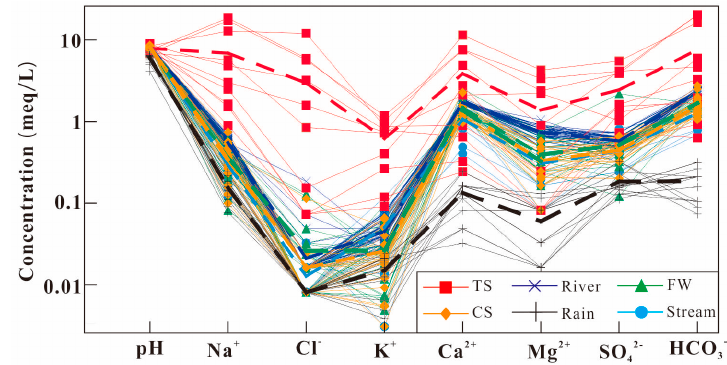
Figure 3. Schöeller diagram for different water samples (unit: meq/L). Dash lines stand for the mean values of different water samples. TS: Thermal spring, CS: Cold spring, FW: Fractured water.